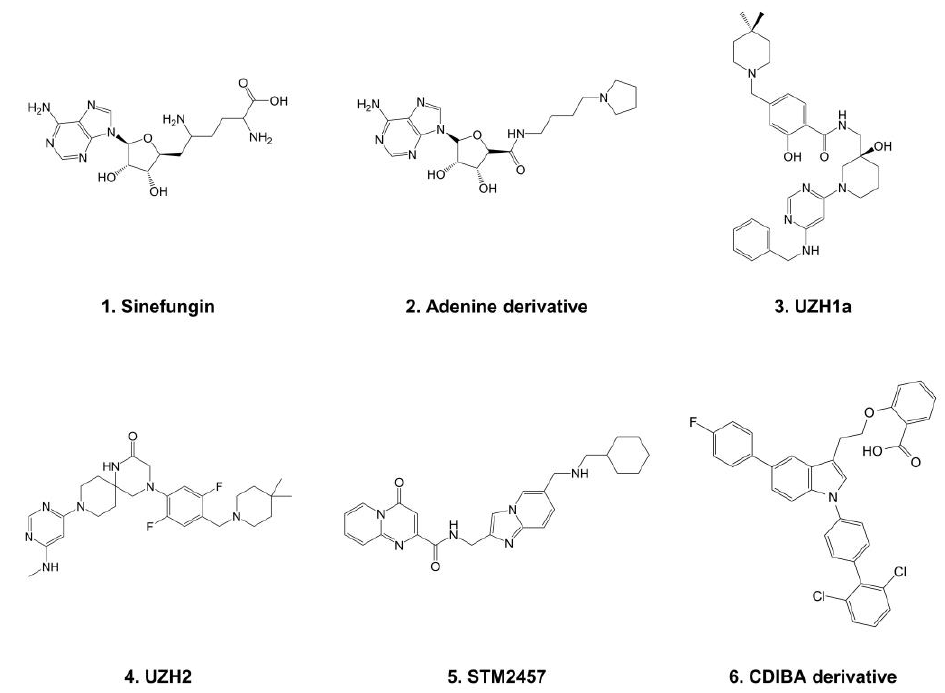
Figure 1. Chemical structures of current METTL3-14 inhibitors.